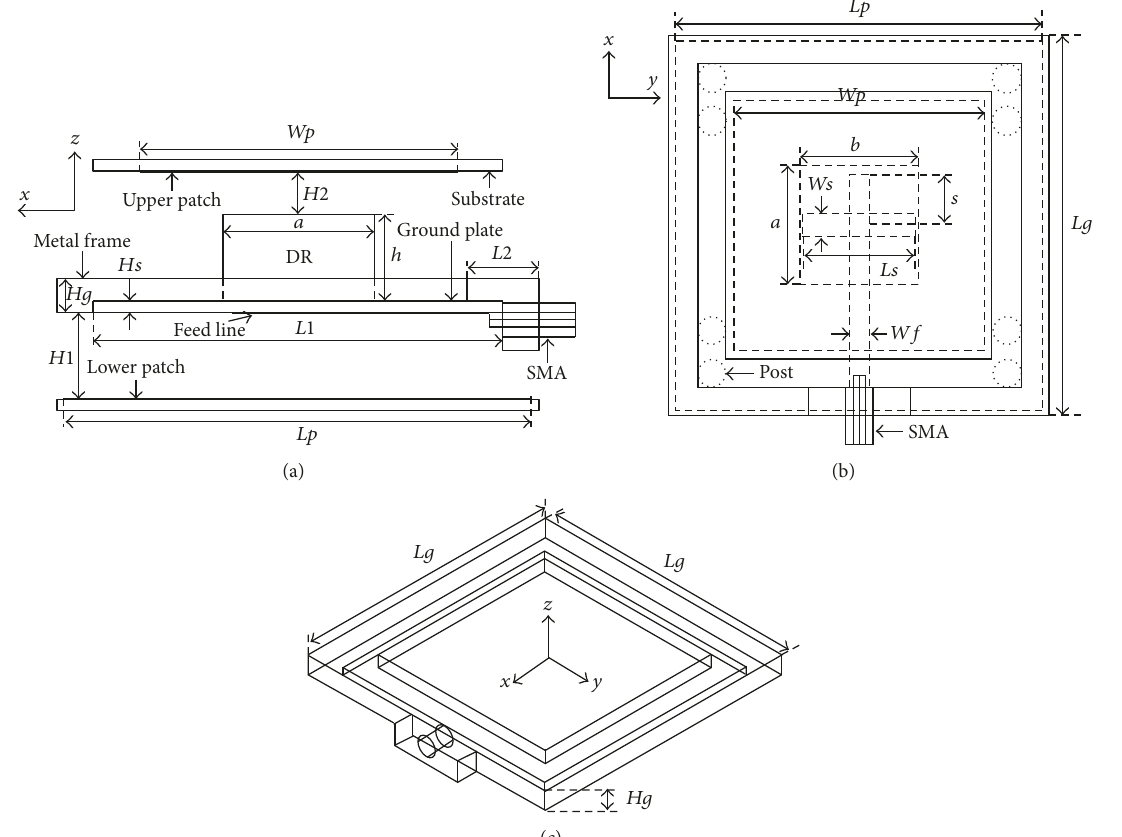
Figure 1: Geometry of the proposed DRA. (a) Side view. (b) Top view. (c) Metal frame.